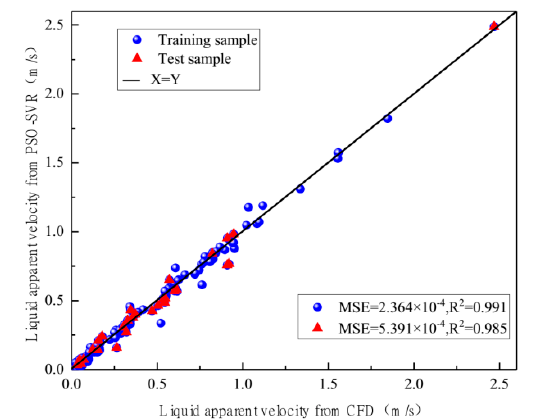
Figure 4. The prediction results of training and test samples.